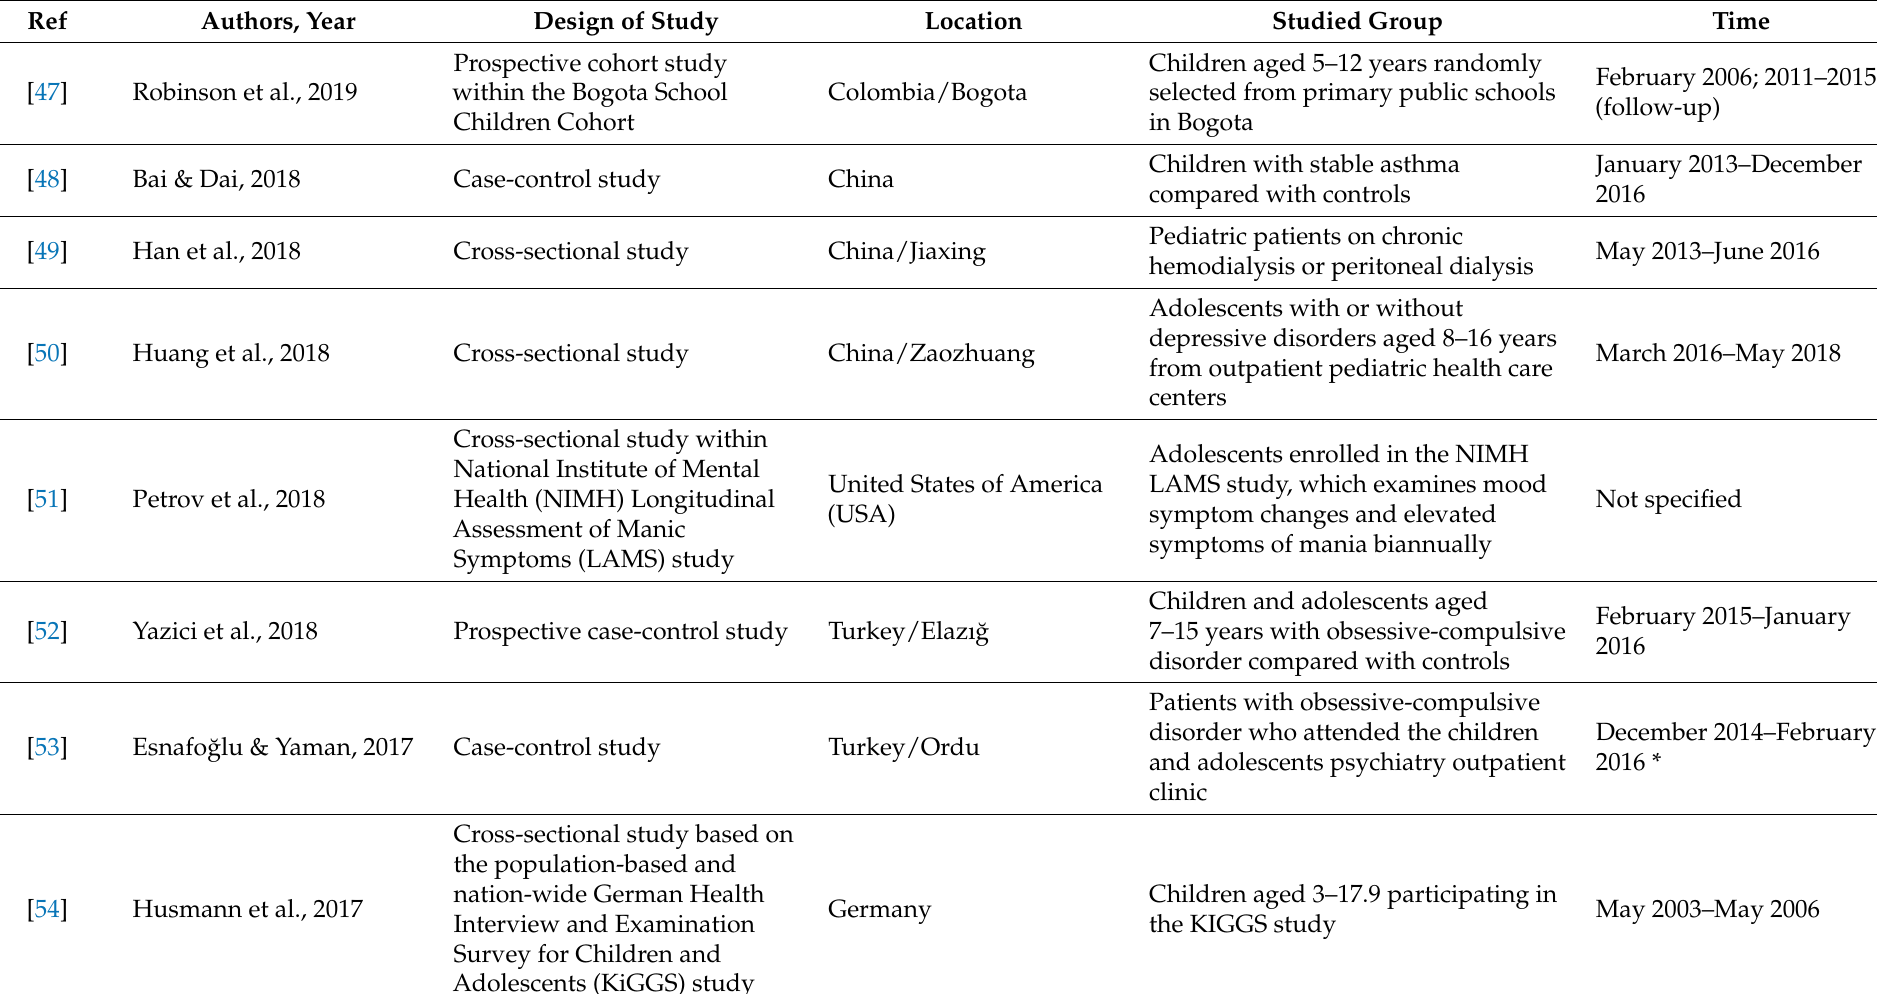
Table 6. The basic characteristics of the included observational studies, including study design, location, studied group and